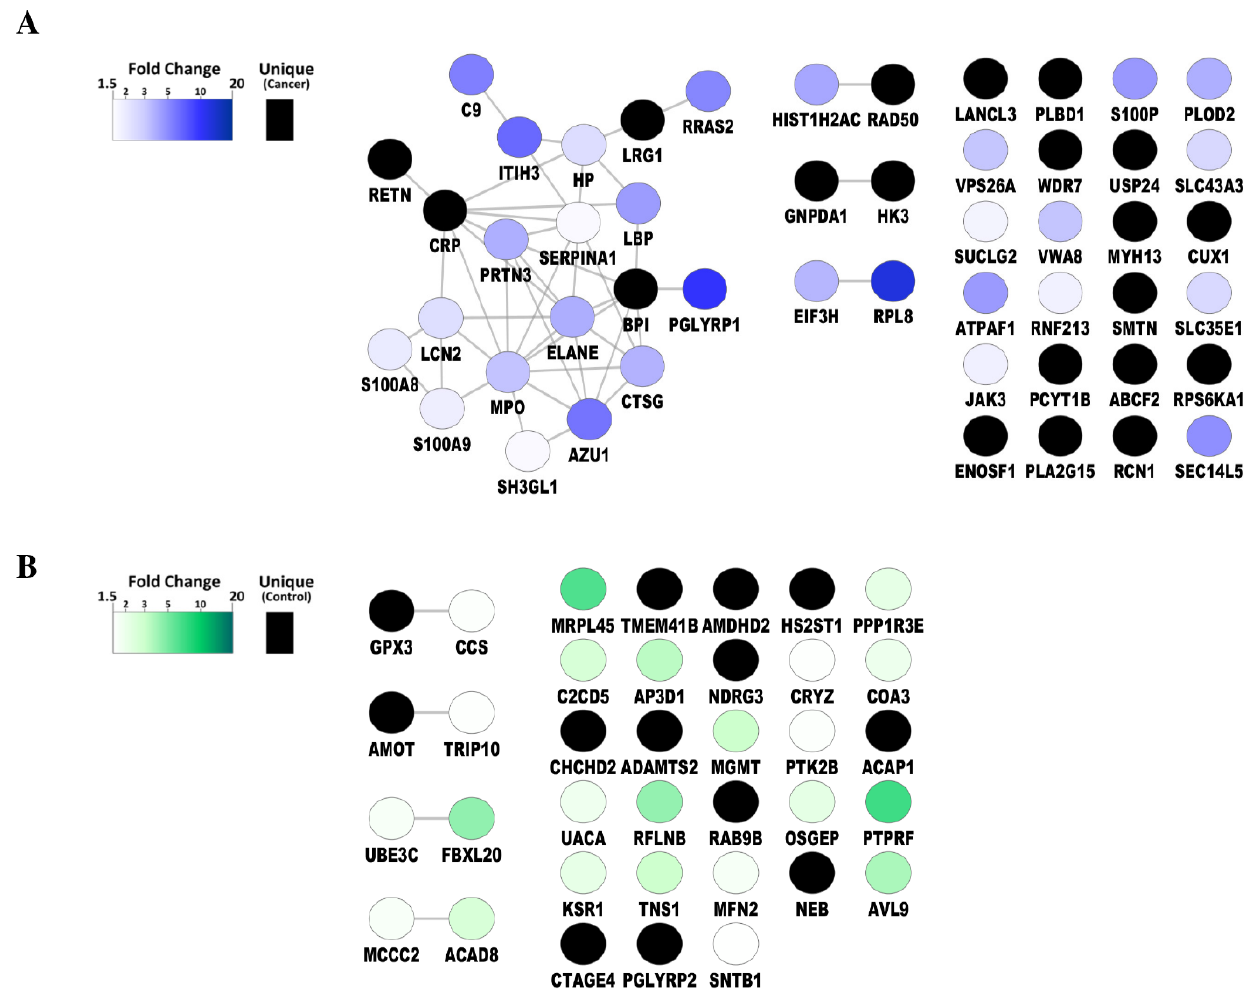
Figure 3. Protein–protein networks of significantly upregulated platelet proteins ( A ) in patients with cancer compared to healthy volunteers, ( B ) in healthy volunteers compared to patients with cancer. ( p < 0.05, fold change ≥ 1.5).